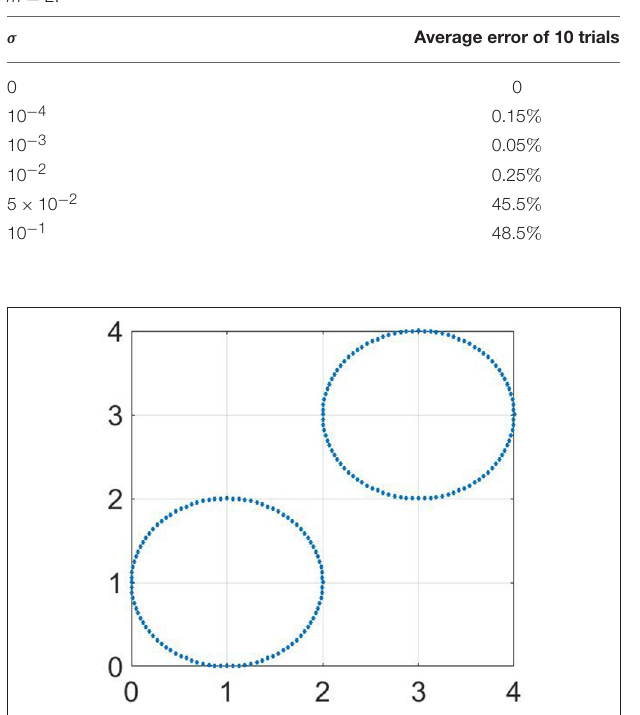
FIGURE 3 | Testing dataset of two non-intersecting circles.